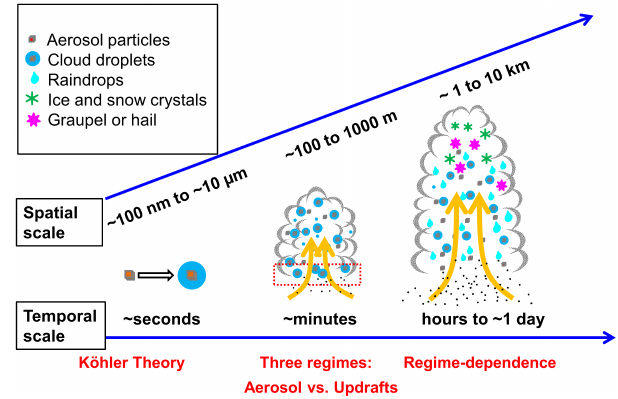
Figure 23. Overview of the research approaches on multi-scale cloud initialization and development. The aerosol–cloud interac- tion at the microphysical scale, i.e., cloud condensation nuclei (CCN) activation, has been well characterized by the Köhler the- ory (Kohler, 1936) and by a series of extended equations (Shulman et al., 1996; Kulmala et al., 1997 Laaksonen et al., 1998). When we upscale the activation of a single aerosol particle to aerosol pop- ulations at the cloud base, the impact of aerosols on the number of activated CCN still appears simple and can be well described (i.e., the three generic regimes of CCN activation). When consider- ing full microphysics and the larger temporal and spatial scales of a single pyro-convective cloud, the performance of ensemble simula- tions shows the regime dependence of aerosol effects on the pyro- convective cloud formation and